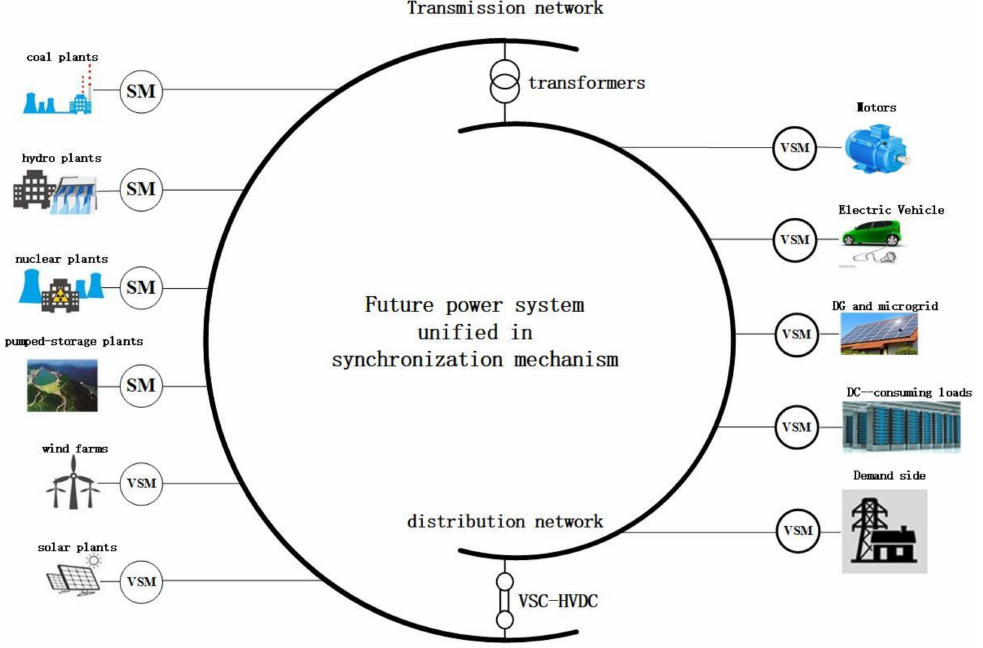
Figure 13. Universal compatibility architecture of future power